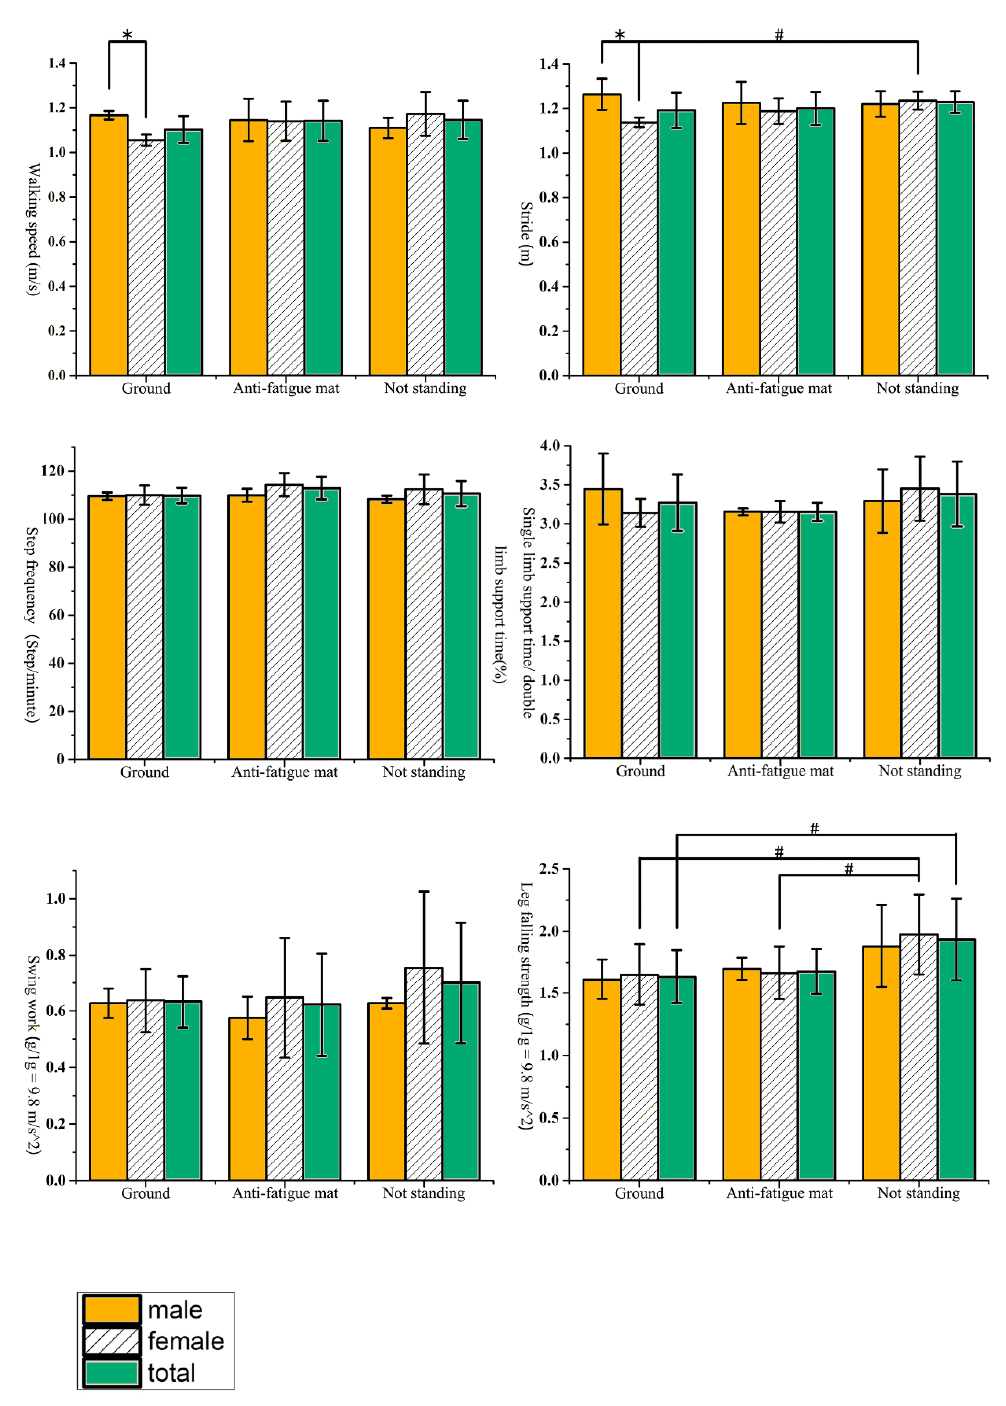
Figure 6. Gait parameters after standing for 4 h on surfaces with different hardness and gender. *, Under the same intervention conditions, there are significant differences in this index between females and males. #, Under the condition of the same sex, there was a significant difference in this index between standing for 4 h and not tired.